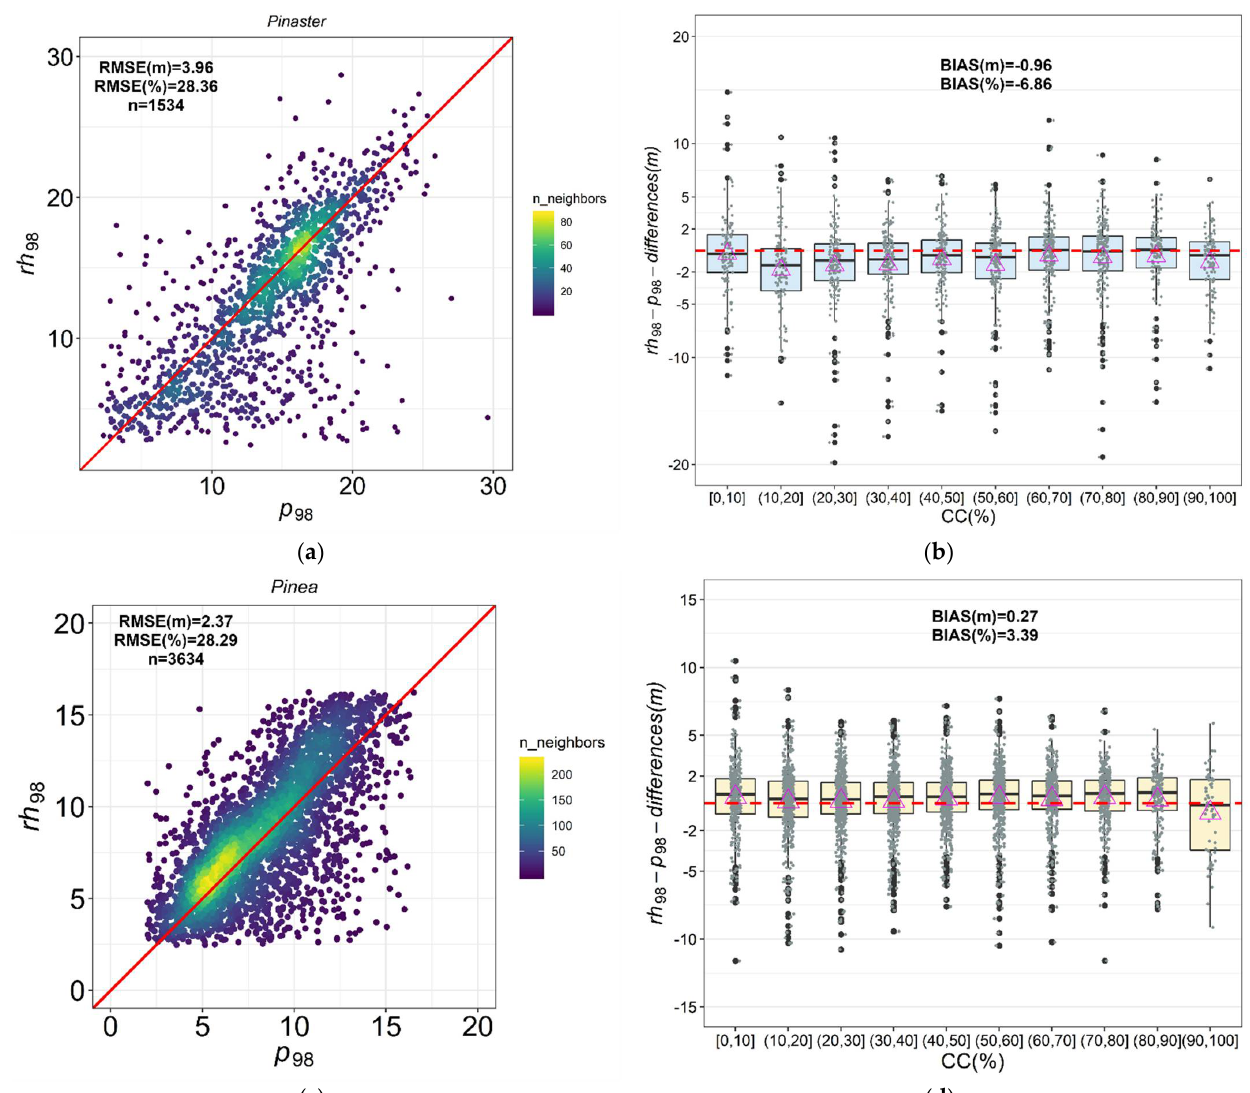
Figure 2. Scatterplots between ALS and GEDI-derived metrics for p 98 rh98 and mean difference between ALS and GEDI metrics by CC ALS (%): ( a , b ) Dehesas ; ( c , d ) Encinares , and ( e , f ) Alcornocales . The red solid line represents the 1:1 relationship in the scatterplots. Mean values of the differences between rh 98- p 98 (triangle). The dashed red line represents y = 0 in boxplots.